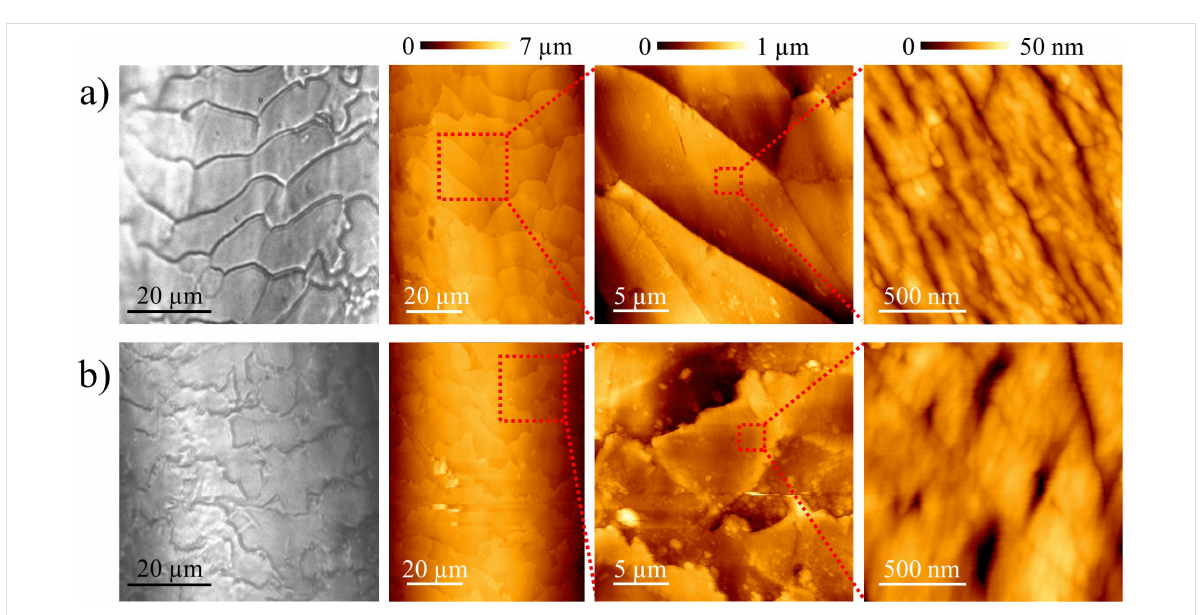
Figure 4: Images of sample 1 (a) and 2 (b) cleaned surfaces, showing geometrical differences at various scales.